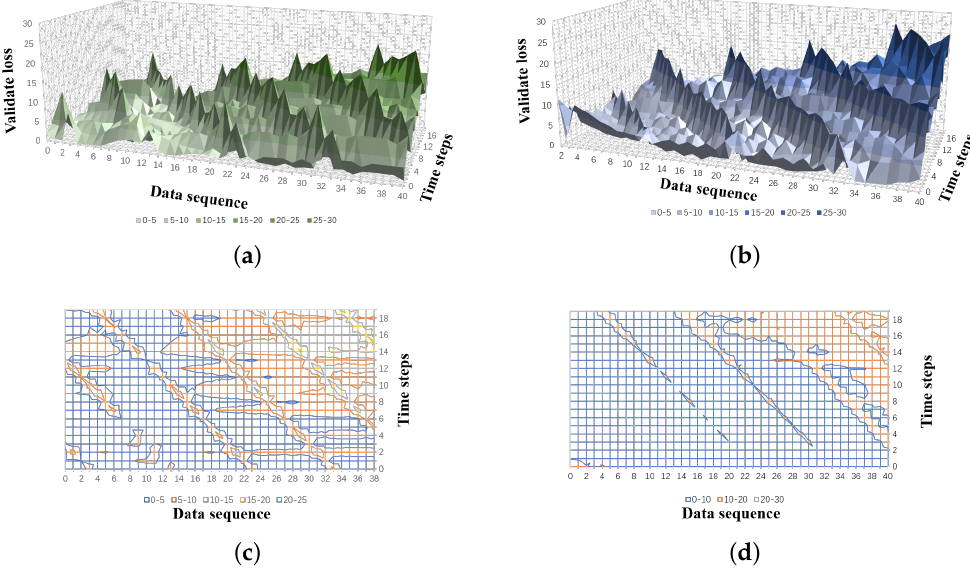
Figure 7. The prediction loss at each step in 3d and 2d perspective. ( a ) The validation loss of CNN– LSTM. ( b ) The validation loss of LSTM. ( c ) The validation loss of CNN–LSTM. ( d ) The validation loss of